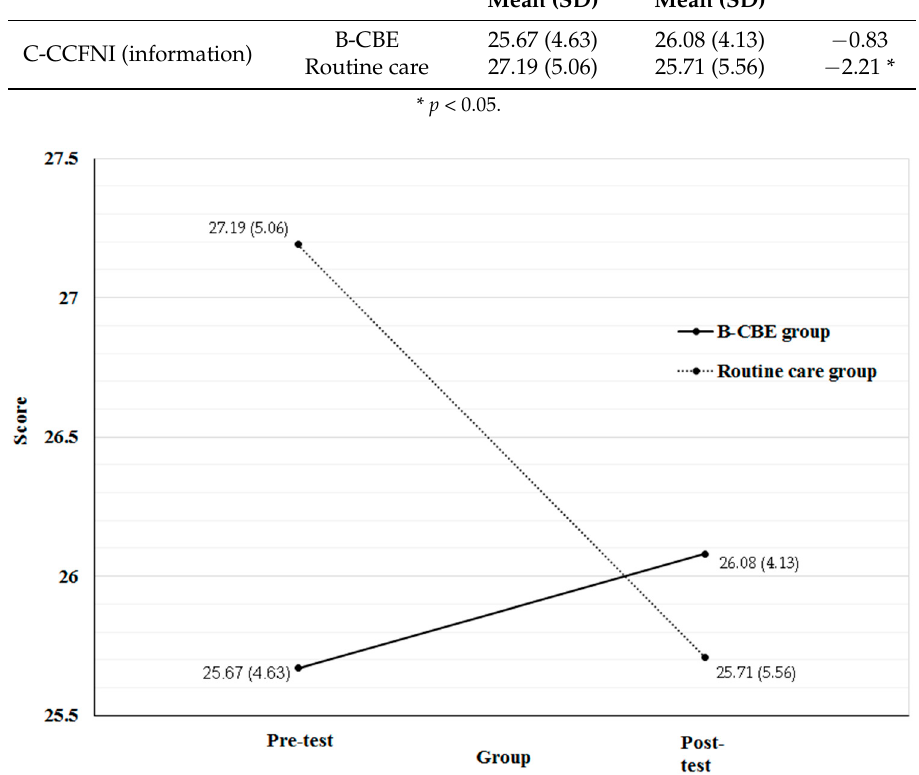
Figure 2. Visualization of the pre–post measurements on information satisfaction.